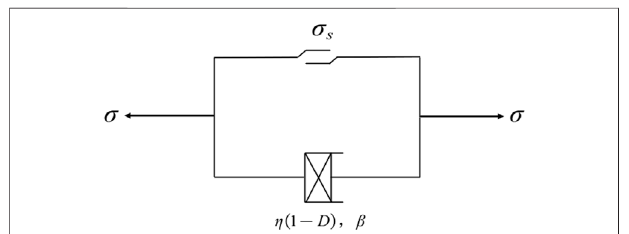
FIGURE 4 | Viscoplastic damage